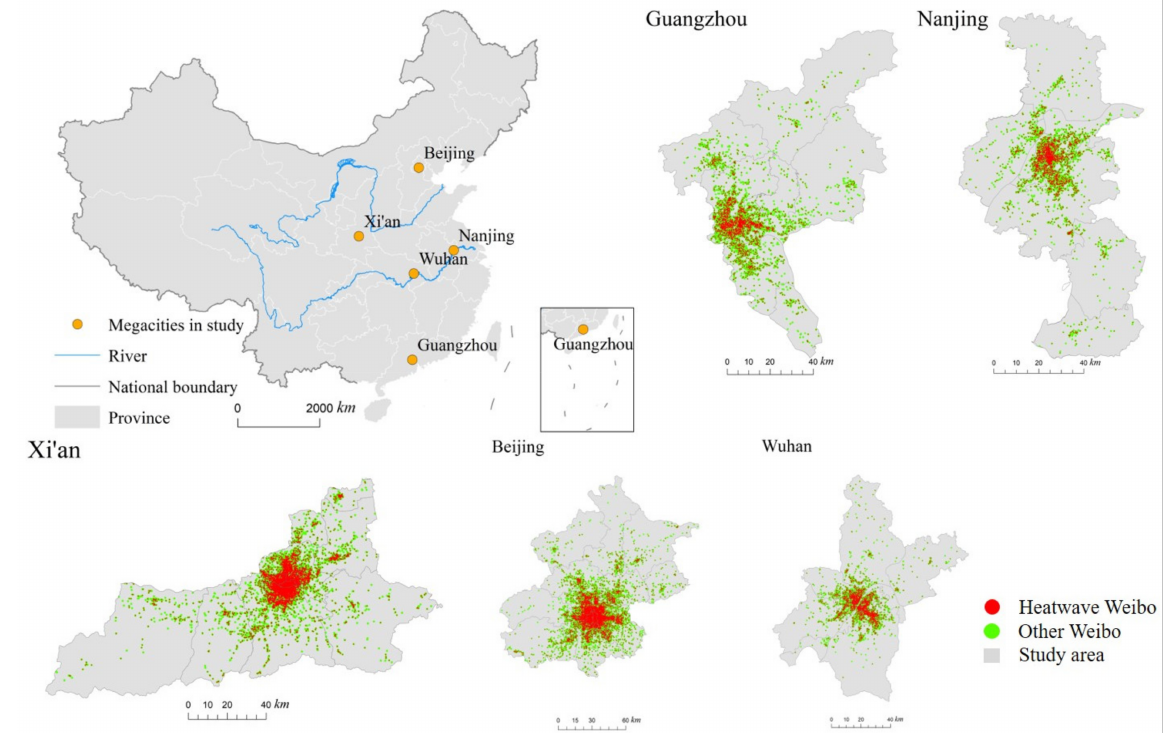
Figure 1. Study area and Weibo data used in this